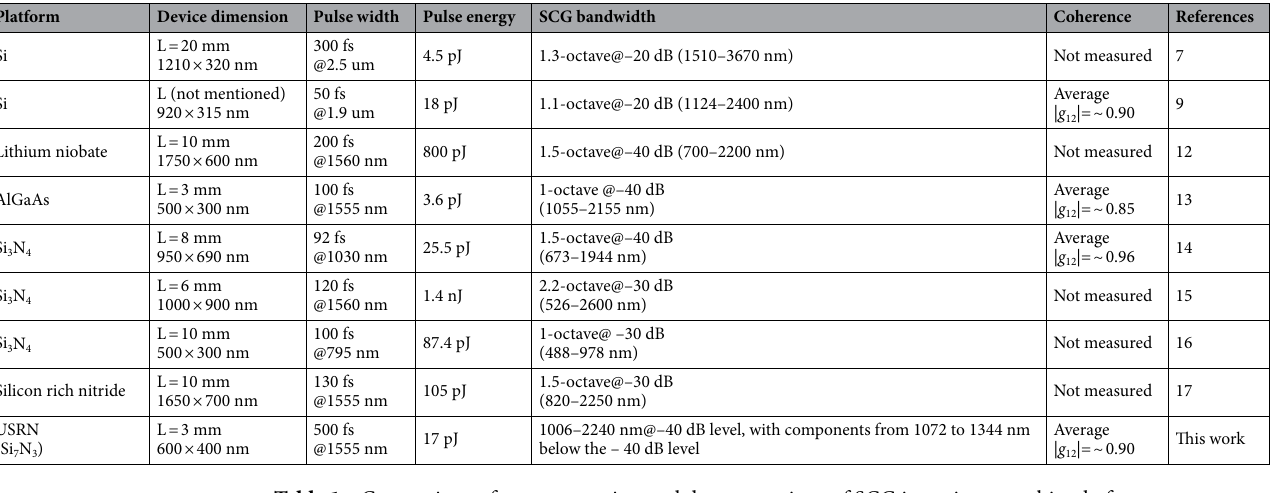
Table 1. Comparison of recent experimental demonstrations of SCG in various on-chip